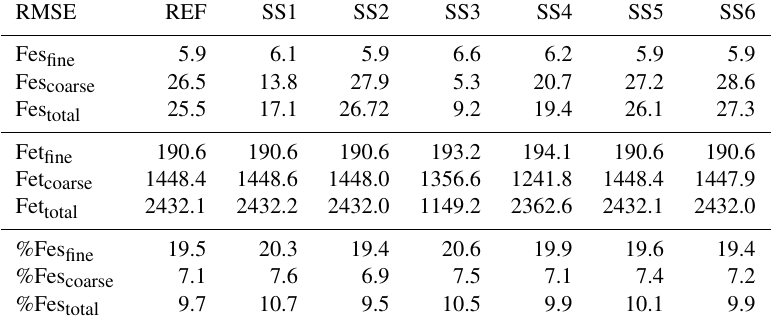
Table 2. Root mean square error (RMSE) for the reference case (REF) and for sensitivity studies 1–6. REF: proton-promoted and oxalate- promoted iron dissolution; SS1: proton-promoted iron dissolution; SS2: REF with oxalate dependent on sulfate; SS3: simple cloud param- eterization for iron dissolution (Hand et al., 2004); SS4: REF with no spatial dependence on mineralogy; SS5: REF, pH = 1; SS6: SS2, pH =